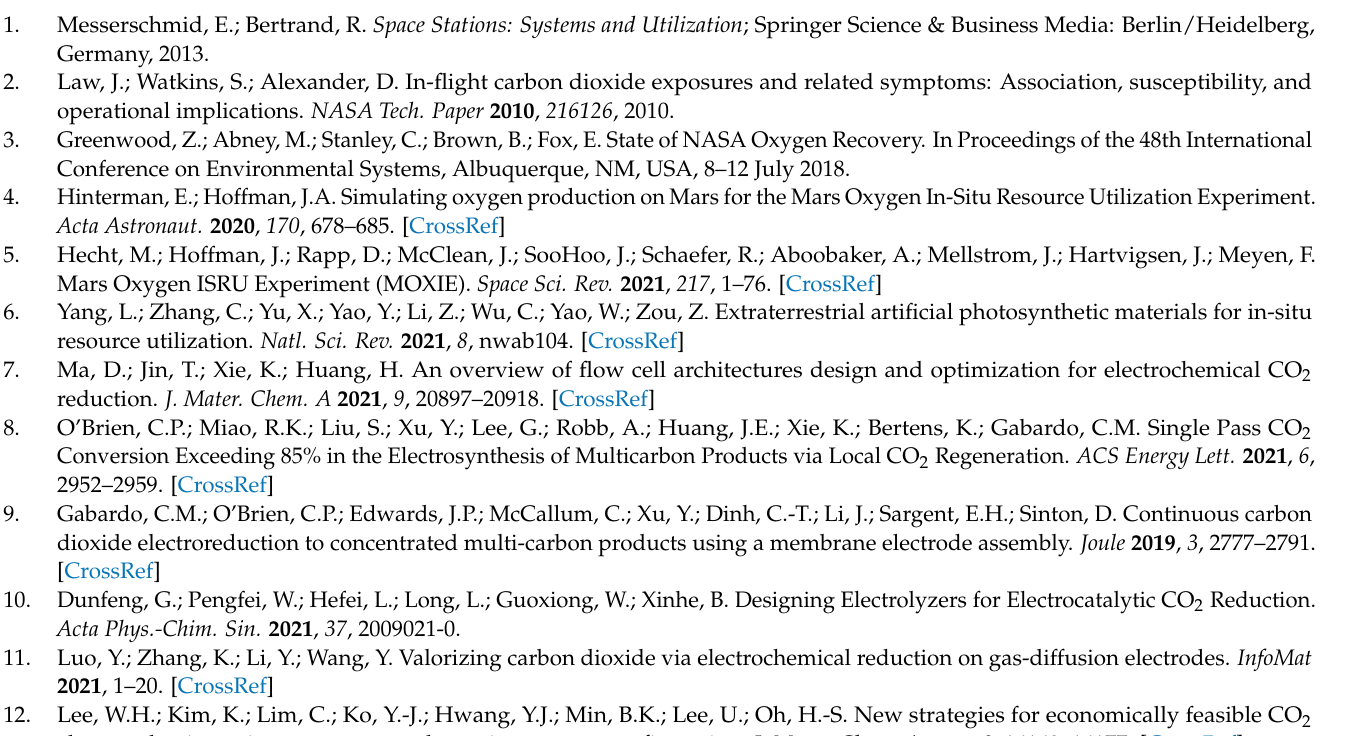
Table S3: Concentrations of Cu and Ir in the anodic solution before and after the